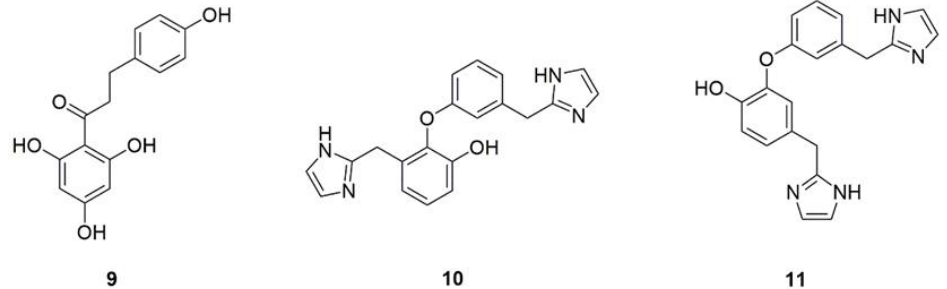
Figure 5. Chemical structures of natural compounds targeting invasive enzymes.